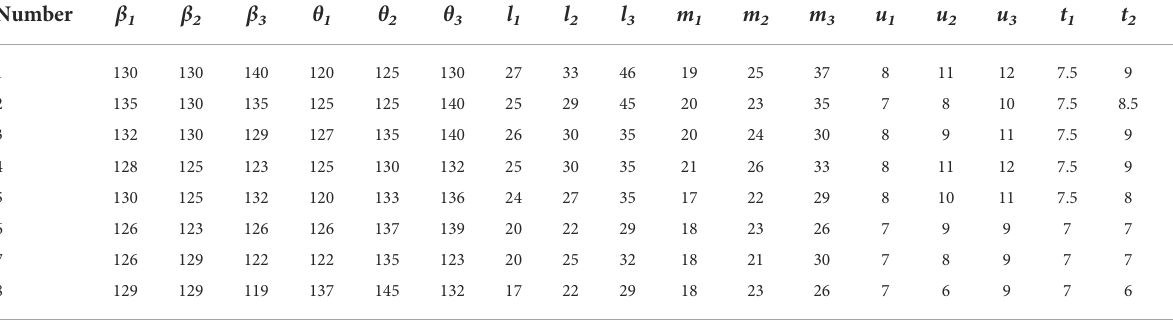
TABLE 2 Parameters of the interest region (Unit of length: mm; Unit of Angle: ° ).